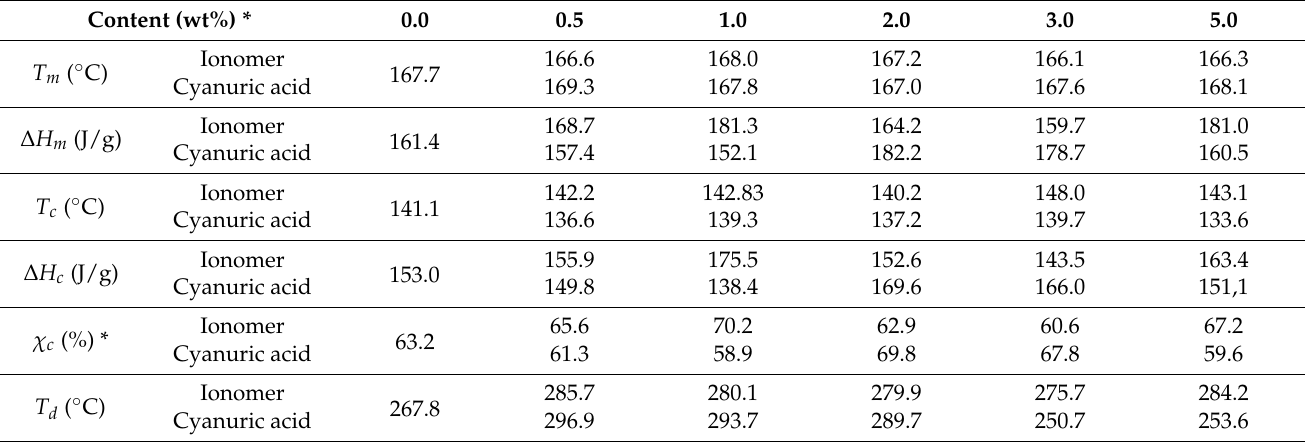
Table 4. Thermal properties of pristine POM, POM/CNT (POM/C1.5),